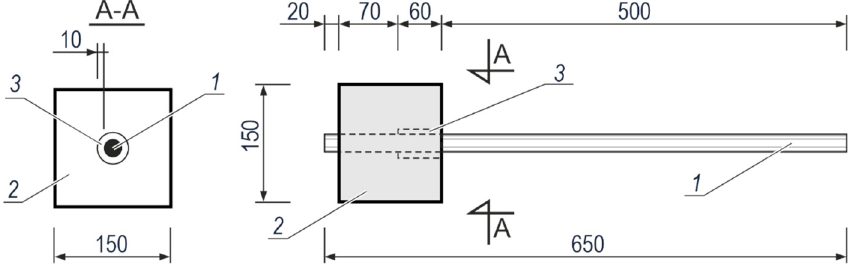
Figure 1. The test element used to test bond of galvanized and black steel to concrete with or without chlorides: 1 —steel rebar, 2 —concrete specimen, 3 —a 10 mm thick sleeve made of polyurethane foam with mineral filler (dimensions in millimetres).